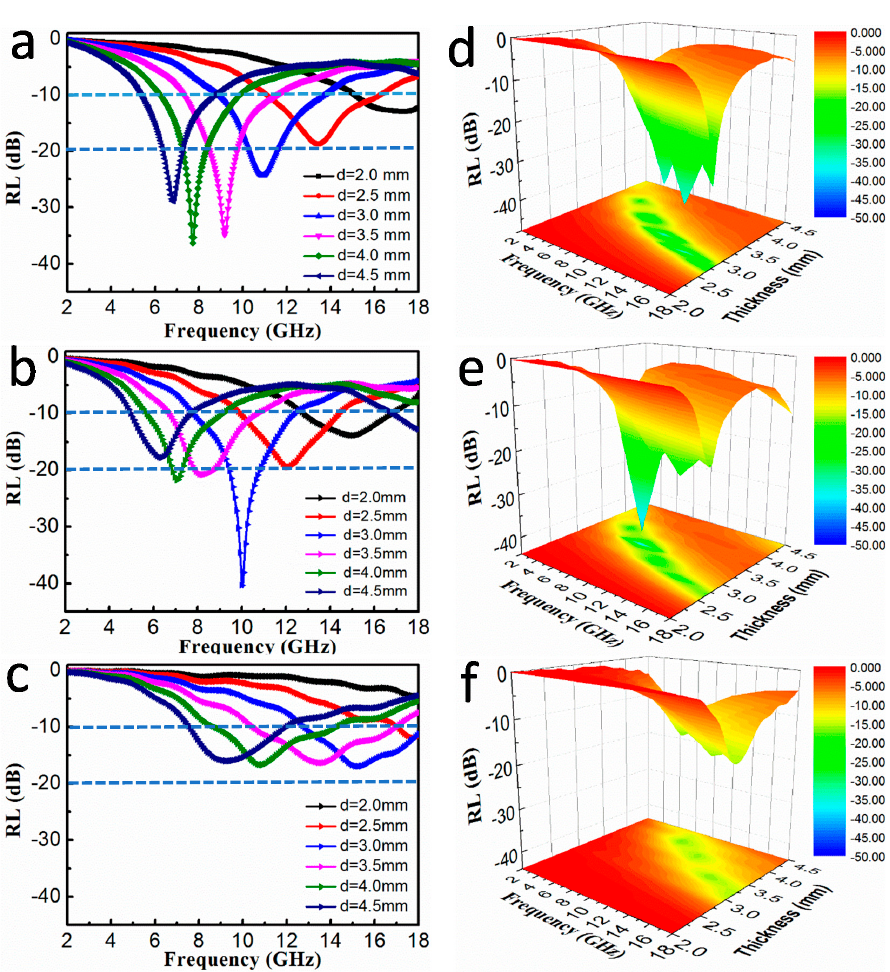
Figure 7. Frequency dependence of RL curves at different thicknesses of ( a ) S1, ( b ) S2, and ( c ) S3 with a filler loading ratio of 30 wt%. Three-dimensional diagrams of RL values for ( d ) S1, ( e ) S2, and ( f ) S3. It is known that, the MA properties of an absorber are highly dependent on the relative complex permittivity ( (cid:2013) r = (cid:2013) (cid:4593) − (cid:1862)(cid:2013) (cid:4593)(cid:4593) ) and relative complex permeability ( (cid:2020) (cid:3045) = (cid:2020) (cid:4593) − (cid:1862)(cid:2020) (cid:4593)(cid:4593) (cid:4667) . Generally, the real parts ( (cid:2013) (cid:4593) and (cid:2020) (cid:4593) ) and imaginary parts ( (cid:2013) (cid:4593)(cid:4593) and (cid:2020) (cid:4593)(cid:4593) ) represent the storage and dissipation capabilities of electric and magnetic energy, respectively [39]. The dielectric loss tangents ( tanδ (cid:2965) = ε (cid:4593)(cid:4593) /ε (cid:4593) ) and magnetic loss tangents ( tanδ (cid:2972) = μ (cid:4593)(cid:4593) /μ (cid:4593) ) are widely used to evaluate the dielectric loss capability and magnetic loss capability of the absorber.